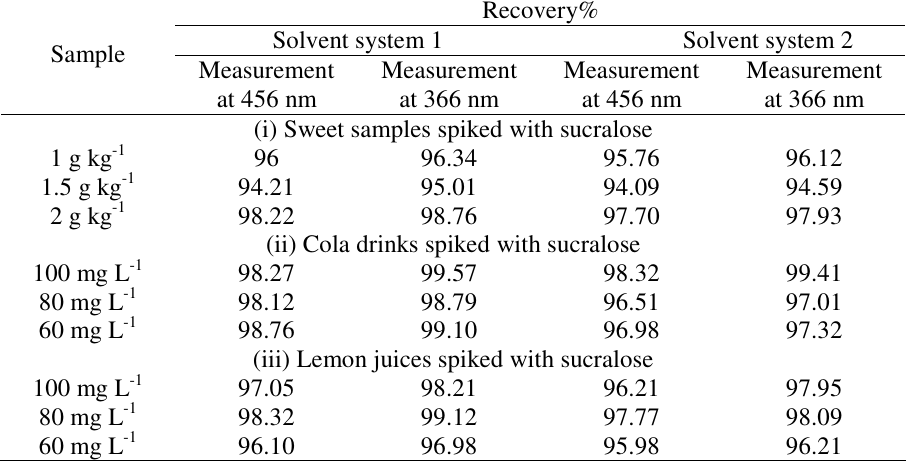
Table 2. Data for recovery of sucralose in spiked samples obtained using two solvent systems after derivatization with rhodamine-sulfuric acid reagent in absorbance mode at 456 nm and in fluorescence mode at 366